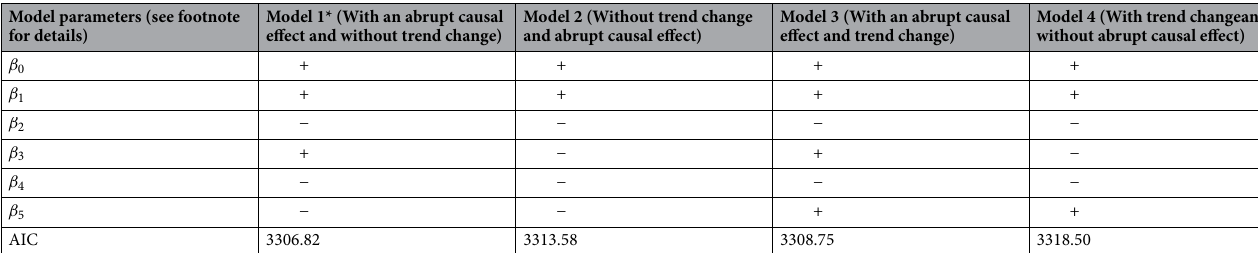
Table 3. Comparison of models that capture the time-dependent variations in the case fatality risk of COVID-19 in seven urban prefectures in Japan. Plus shows what was accounted for, and minus that this was not included in that model. β 0 is the parameter for the baseline level; β 1 , the increase in the outcome following the time-unit increase; β 2 and β 3 , the change in the level at first and second interventions (7 April and 8 May 2020, respectively); and β 4 and β 5 , the change in trend following the first and second interventions (7 April and 8 May 2020, respectively). Seven prefectures include Tokyo, Kanagawa, Saitama, Chiba, Osaka, Hyogo, and Fukuoka.